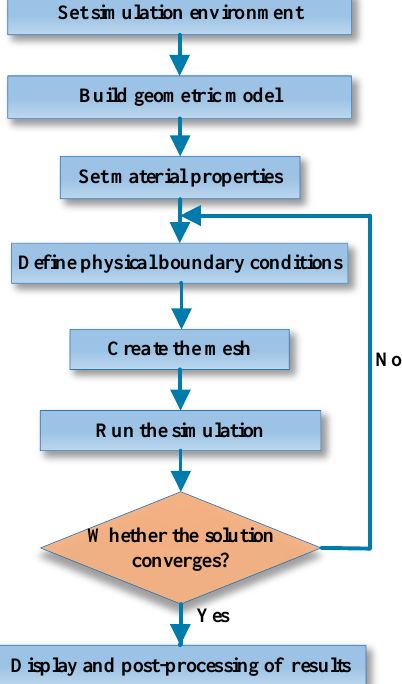
Figure 5. Calculation flowchart of the simulation. Table 1. Particles for parametric sweeps.